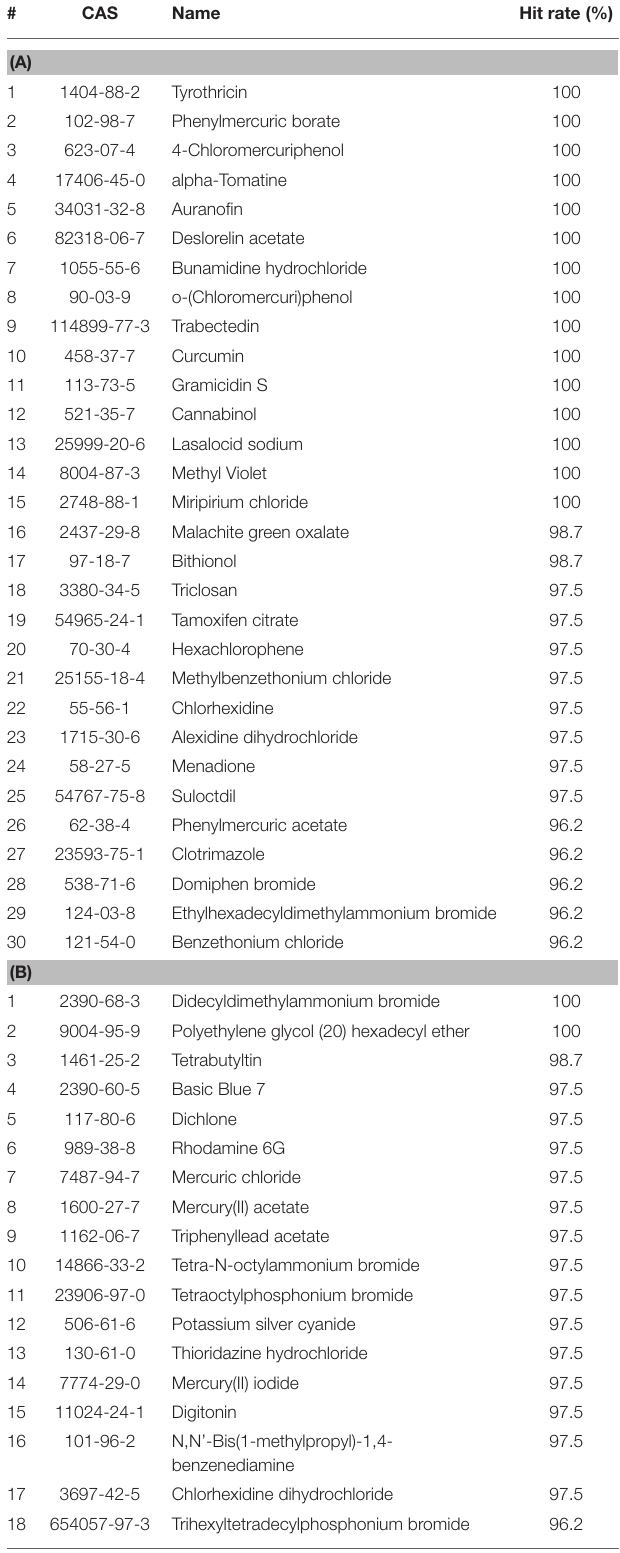
TABLE 2 | Top 30 most active (A) drugs and (B) ENVCs from Tox21 10K library screens based on hit rates against only viability